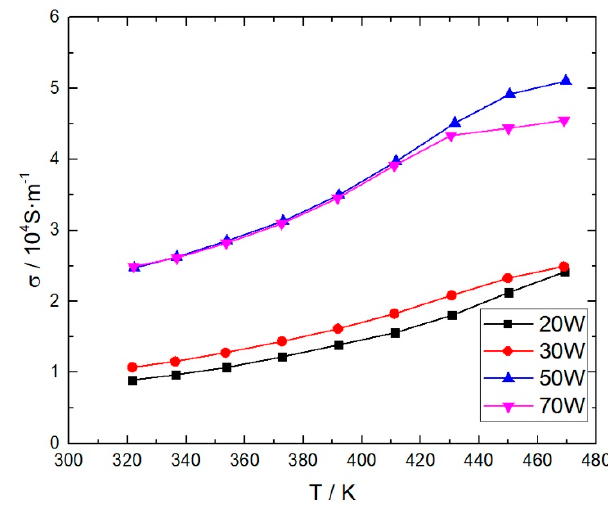
Figure 4. Semiconductor properties of the Bi 2 Te 3 films deposited under different powers by Hall tests